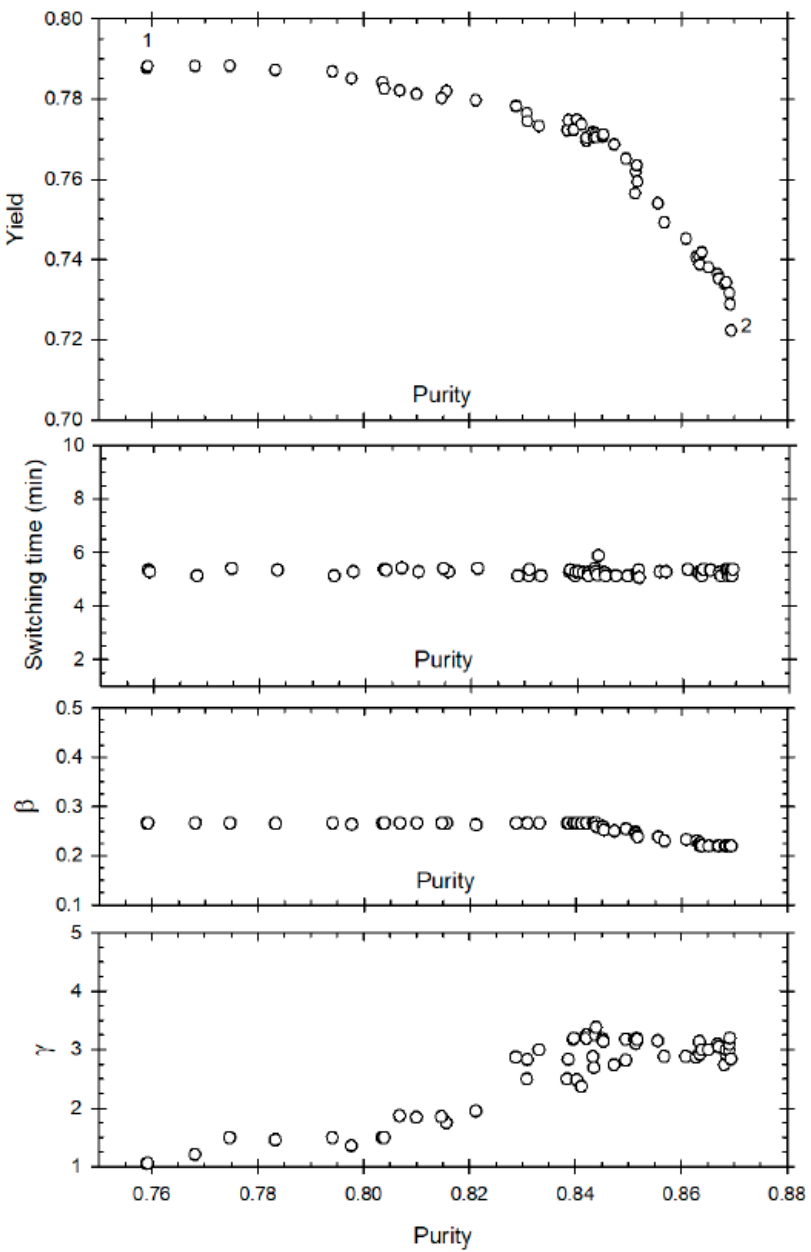
Figure 2. Existing set-up (Case 1.1 Maximization of Yield and Purity): Pareto optimal solutions and corresponding operating variables.